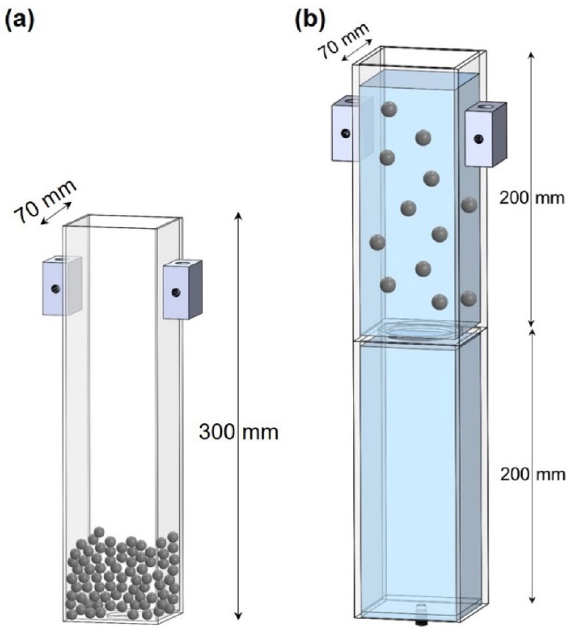
Figure 2. Hoppers. ( a ) Dry granular flow tests. ( b ) Particle-laden fluid flow tests; the dual chamber configuration allows for controlled discharge